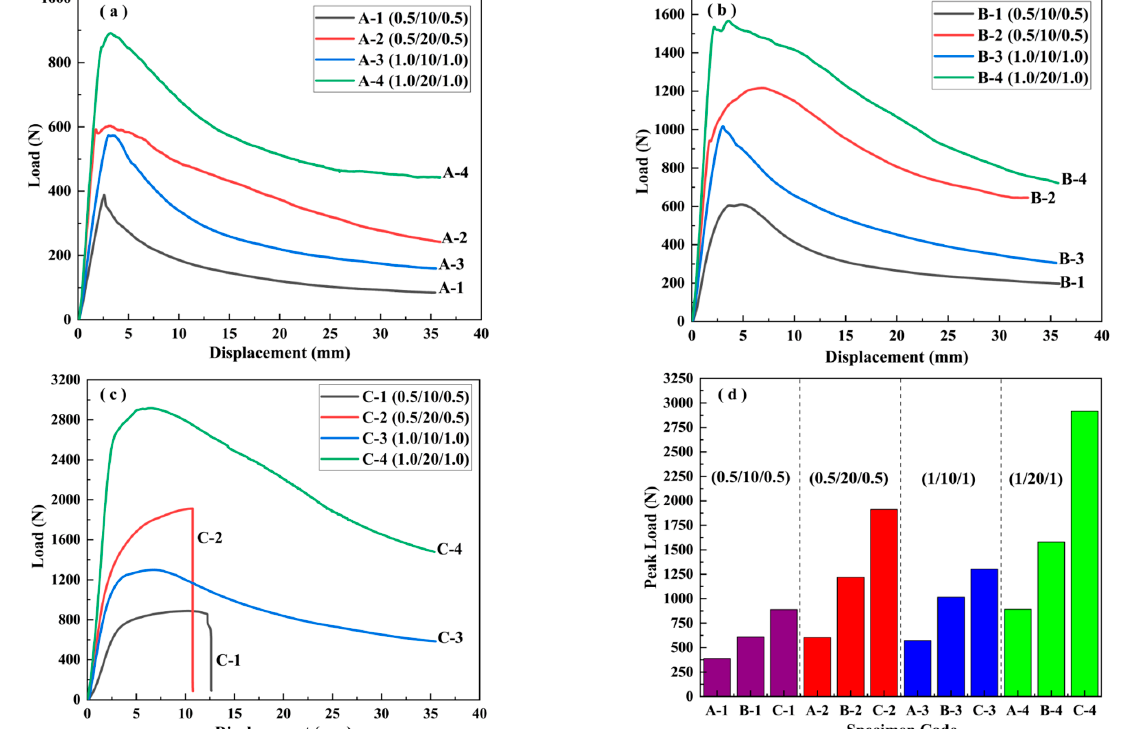
Figure 3. The load–displacement curves of sandwich beams with different core densities under three-point bending: ( a ) A—52 kg/m 3 ; ( b ) B—110 kg/m 3 ; ( c ) C—200 kg/m 3 ; ( d ) the distribution of the peak load.